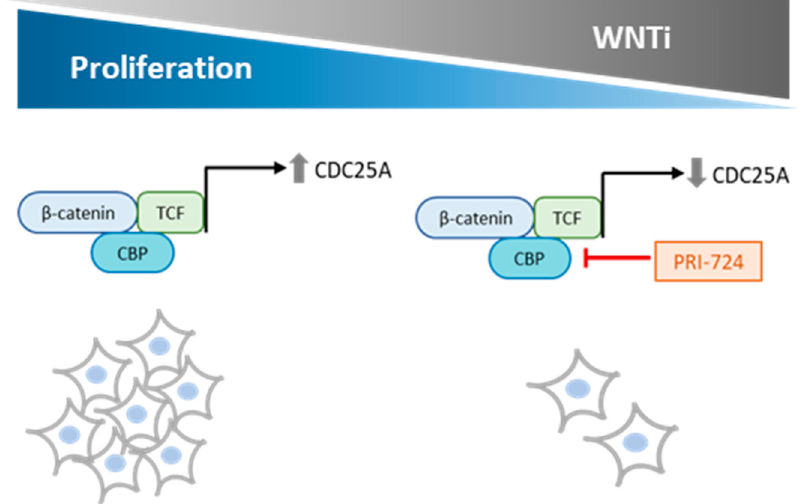
Figure 7. Proposed model for PRI-724 reduction of STS cell proliferation. PRI-724 binds to CBP, leading to inactivation of TCF/CBP/ β -catenin-dependent target gene transcription, such as CDC25A , a major player in STS cell proliferation.